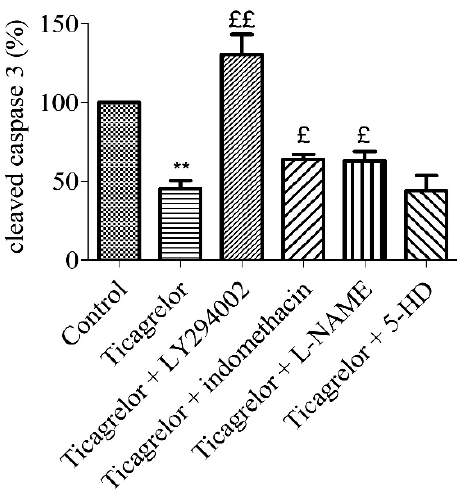
Figure 6. Anti-apoptotic e ff ect of ticagrelor involved PI3K, NOS, and COX. Five minutes prior to 10 µ M ticagrelor treatment, HUVECs were pretreated with di ff erent selective inhibitors of signalling pathways. Thirty minutes after ticagrelor treatment, cells were exposed to simulated hypoxia for 2 h. Signalling pathways were studied using selective inhibitors pathways of PI3K (10 µ M LY294002), mitoKATP (100 µ M 5-HD), NOS (10 µ M L-NAME) and COX (5 µ M, indomethacin). Data are means ± sem ( n = 6 / group) of relative cleaved caspase 3 expression (%) in HUVECs after 2 h of hypoxia. £: p < 0.05, ££: p < 0.01, compared to 10 µ M ticagrelor group. **: p < 0.01, compared to control without treatment.